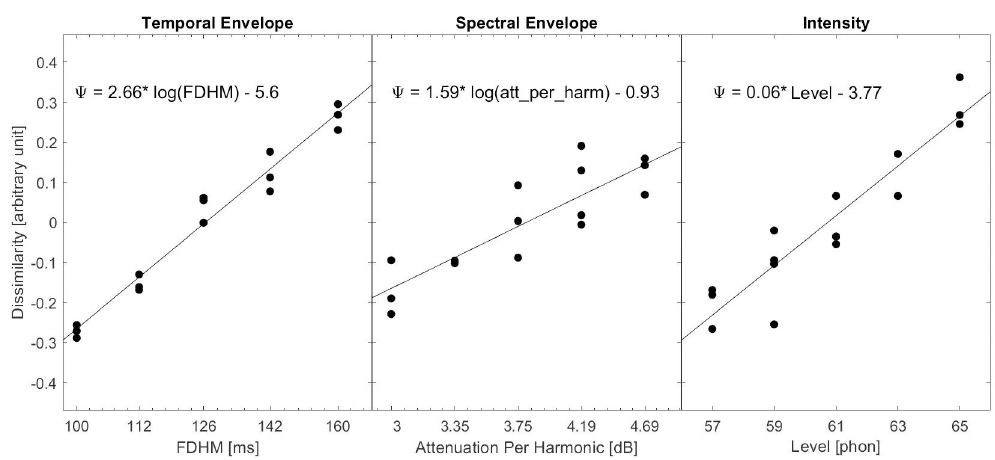
Fig 4. Scatterplot of the perceptual dimensions derived from the MDS analysis against the physical features. The equation in each panel describes the regression line. Logarithmic functions are used for temporal and spectral envelope as in Marozeau et al. [7], Fig 8; they offer better correlation to the perceptual dimensions than linear functions. (11) = 0.93, 95% CIs [0.81, 0.97], p < 0 . 01 ; the second dimension was correlated with the spec- tral envelope values, r (11) = 0.86, 95% CIs [0.63, 0.95], p < 0 . 01 ; and the third dimension was correlated with the intensity values, r (11) = 0.98, 95% CIs [0.95, 0.99], p < 0 . 01 . Based on these relationships, Fig 2 was redrawn with a new scale on the x-axis: Figs 5 and 6 illustrate performance for all three features on the same x-axis dissimilarity scale, for each par- ticipant group. The data were re-analyzed in terms of dissimilarity instead of difficulty level. Dissimilarity was treated as a continuous variable and all other terms remained the same, including factors and their base categories. Table 6 presents a summary of the model including only predictors with R 2 greater than .01 for brevity. Full model specifications can be found in the S1 Appendix. This model included significant main effects of dissimilarity , feature and musical training , but not age group or PTAv . Both dissimilarity and musical training had posi- tive coefficients (1.33 and 0.07, respectively), indicating better performance with increased dis- similarity and musical training, as expected. There were several significant interactions: dissimilarity x feature , dissimilarity x musical training , dissimilarity x feature x musical training , feature x age group , feature x musical training , and feature x age group x musical training . The interaction between age group and musical training was not significant. Interactions including dissimilarity indicate differences in slope between features, as indi- cated by the dissimilarity x feature two-way interaction, and as a factor of musical training, as indicated by the dissimilarity x feature x musical training three-way interaction. According to model coefficients, slopes for both the spectral and temporal envelope manipulations were shallower than the slope for the intensity manipulation, with spectral envelope having the shal- lowest slope. This difference in slopes further interacted with musical training, where very small but positive coefficients indicate that higher Gold-MSI scores were associated with slightly steeper slopes. To confirm the null effect of age, a TOST comparing younger and older adults with lower and upper equivalence bounds of d’ = -0.42 and d’ = 0.42, equivalent to a Cohen’s d of 0.2. The equivalence test was significant, t (6300) = -4.86, p < .01, indicating that the effect, Δ d’ = 0.16 CIs [0.08, 0.25], was different from zero, where younger adults had higher d’ scores than older adults. However, the effect and its CIs fall within the equivalent bounds, meaning that the effect is also equivalent to zero. In other words, the effect is not bigger than the smallest inter- esting effect size and therefore can be considered negligible.